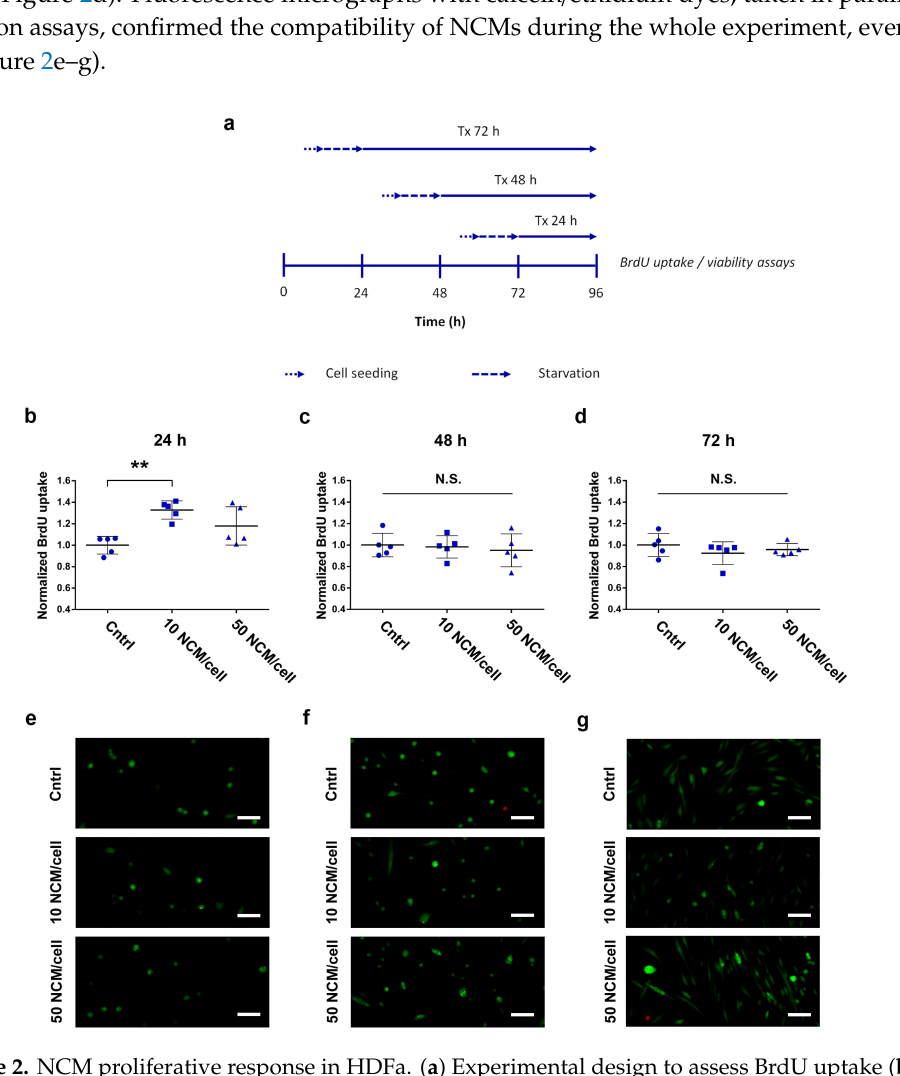
Figure 2. NCM proliferative response in HDFa. ( a ) Experimental design to assess BrdU uptake ( b – d ) and cell viability ( e – g ) after treatment with NCMs at di ff erent doses and exposure times. ( b – d ) BrdU uptake in human fibroblasts after 24 h ( b ), 48 h ( c ) and 72 h ( d ) of treatment; ( e – g ) Representative confocal fluorescence images of cells probed with the live / dead viability kit (green, living cells; red, dead cells) 24 h ( e ), 48 h ( f ) and 72 h ( g ) after treatment with NCMs. **, p < 0.01; N.S., nonsignificant ( p > 0.05). Scale bars, 45 µ m. Cntrl, control with no NCM